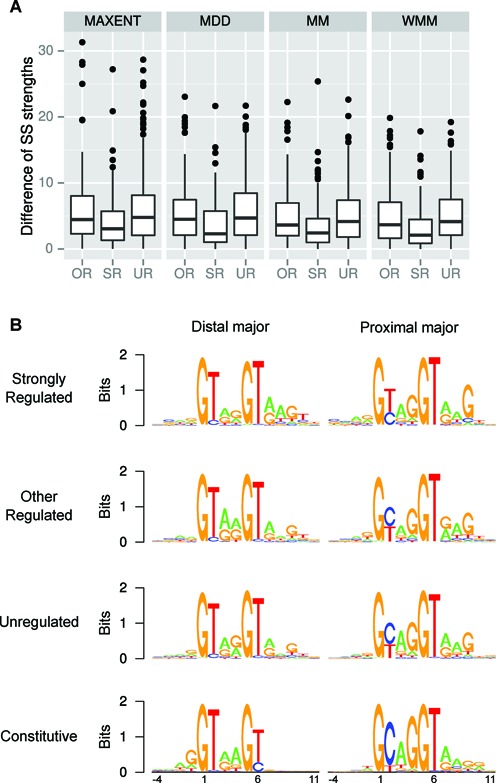
The two tandem splice sites in each strongly regulated GYNNGY are more similar to each other than those in GYNNGYs under weaker or unregulation. (A) Comparison of absolute splice score (SS) differences among different groups. SR, strongly regulated; OR, other less regulated; UR, unregulated. Splice site scores are measured with four different methods (‘MAXENT’, ‘MDD’, ‘MM’ and ‘WMM’). All comparisons are significant (Wilcoxon rank sum test, all P < 0.001). (B) The consensus sequences of GYNNGY splice sites. For each group, the GYNNGYs are further divided into two: one mainly using the first GY (distal major) and one mainly using the second GY (proximal major).